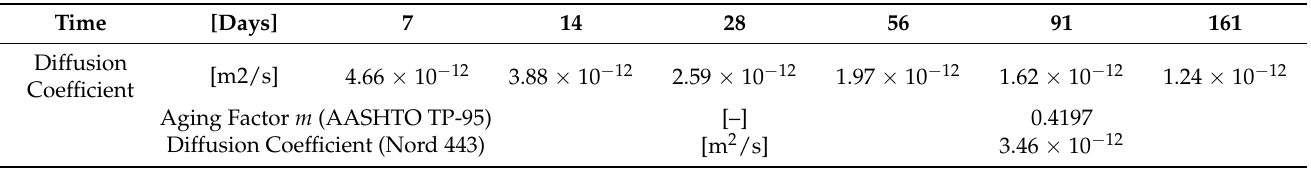
Table 4. Diffusion coefficient and aging factor—HPC1.